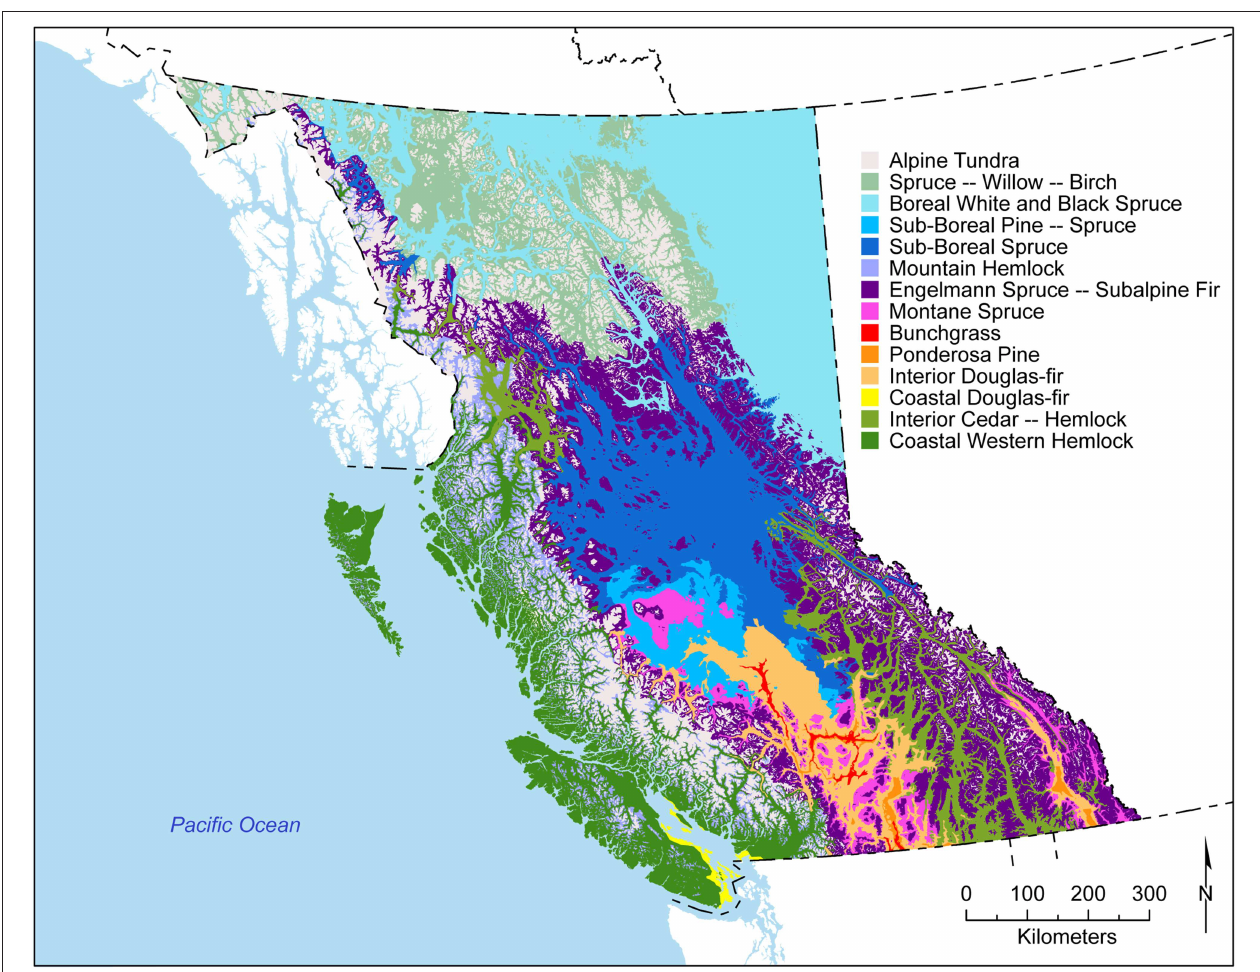
FIGURE 4 | Biogeoclimatic zones of British Columbia (Meidinger and Pojar, 1991). Alpine Tundra includes the Boreal Altai Fescue Alpine, Coastal Mountain-heather Alpine, and Interior Mountain-heather Alpine zones. Data source: British Columbia Ministry of Forest Lands and Natural Resource Operations; map by Raphaël Chavardès and Shuojie